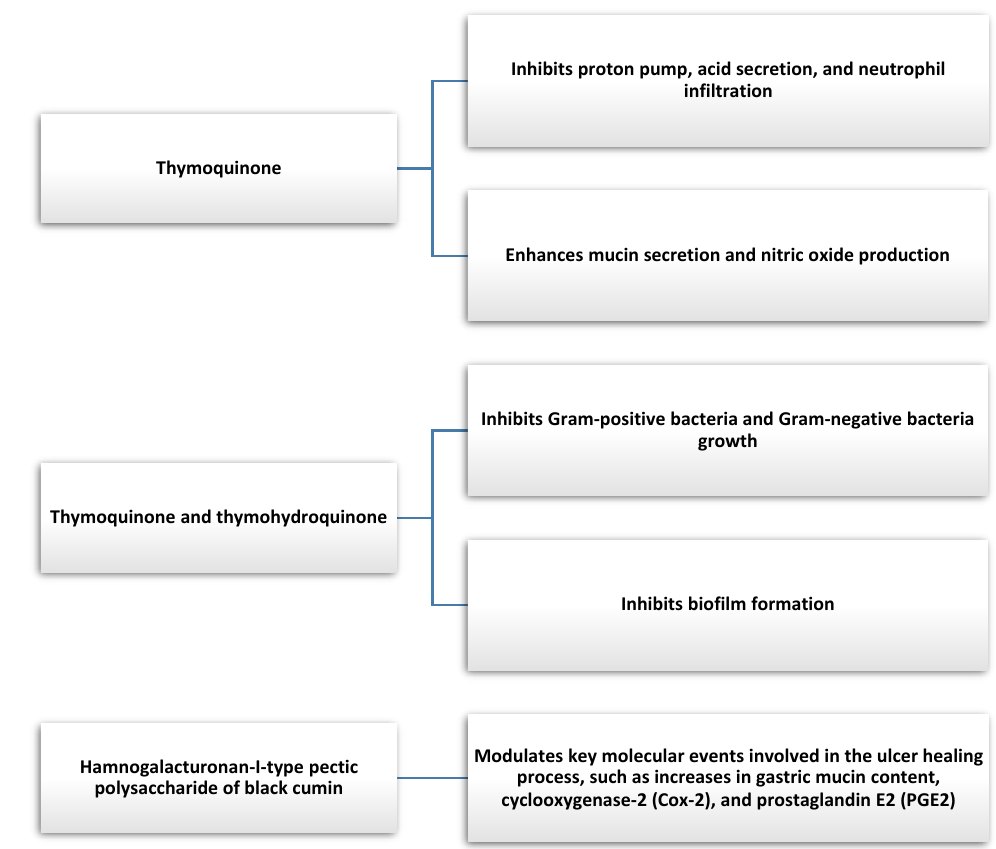
Figure 5. Gastroprotective effect of bioactive compounds found in Nigella Sativa [89,90].